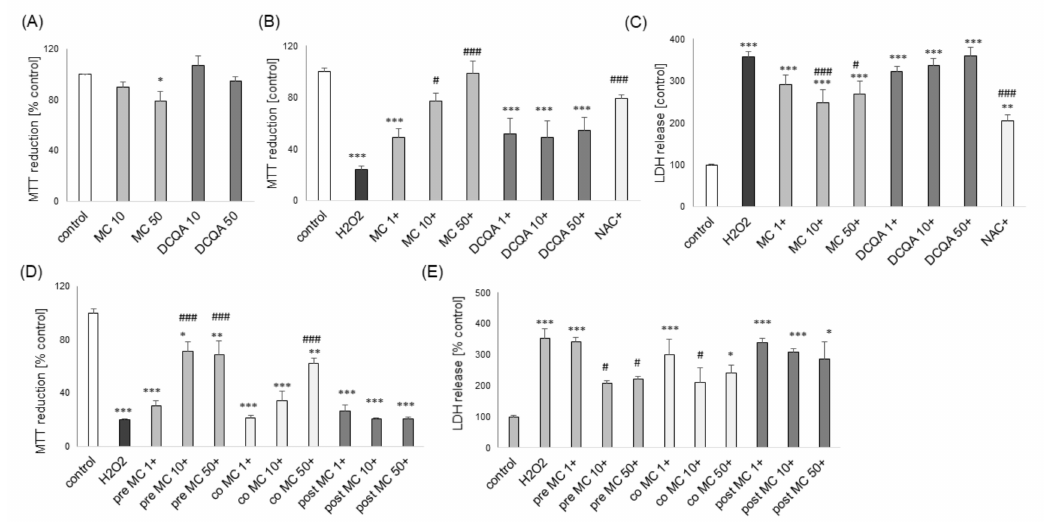
Figure 9. The e ff ect of MC on H 2 O 2 -induced cell damage in primary neuronal cell cultures. ( A ) The e ff ect of MC (10 and 50 µ M) or 3,5-DCQA (10 and 50 µ M) on cell viability in primary neuronal cell cultures after 24 h of treatment as measured with MTT reduction assay. ( B , C ) Cell viability (B) and toxicity ( C ) in primary neurons pre-treated for 30 min. with MC (1–50 µ M) or 3,5-DCQA (1–50 µ M), or co-treated with N-acetylcysteine (NAC, 1 mM) followed by 24 h of treatment with H 2 O 2 (0.2 mM) as measured by MTT reduction ( B ) and LDH release ( C ) assays. ( D , E ) Cell viability ( D ) and toxicity ( E ) in primary neurons pre-treated (30 min. before H 2 O 2 ), co-treated and post-treated (30 min. after H 2 O 2 ) with MC (1-50 µ M) followed by 24 of treatment with H 2 O 2 (0.2 mM) as measured by MTT reduction ( D ) and LDH release ( E ) assays. Data were normalized to vehicle-treated cells and are presented as the mean ± SEM. *** p < 0.001, ** p < 0.01 and * p < 0.05 vs. vehicle-treated cells; ### p < 0.001 and # p < 0.05 vs. H 2 O 2 -treated cells.